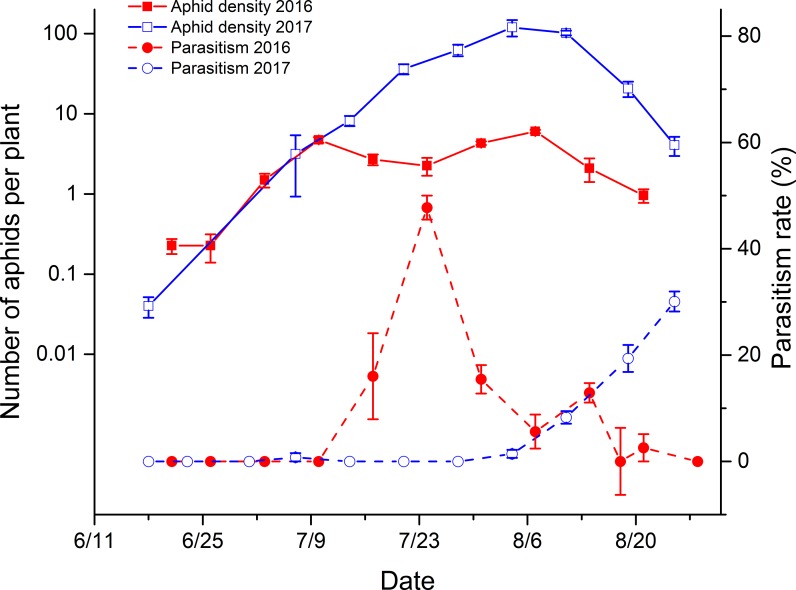
Population dynamics of cotton aphids and their level of parasitism in Changji, China (2016 and 2017).The data in the figures were shown as the mean ± SE.